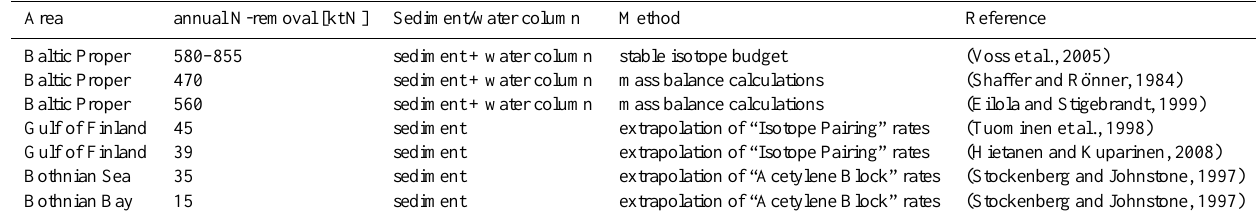
Table 5. N-removal rates from other studies for several sub basins of the Baltic Sea.